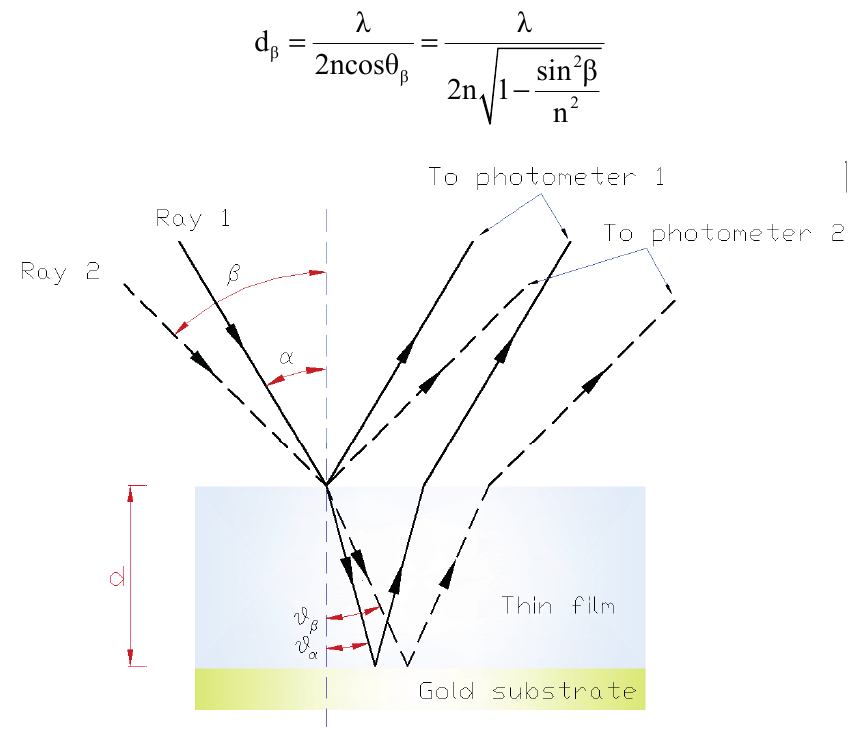
Figure 10. Ray diagram when using two laser